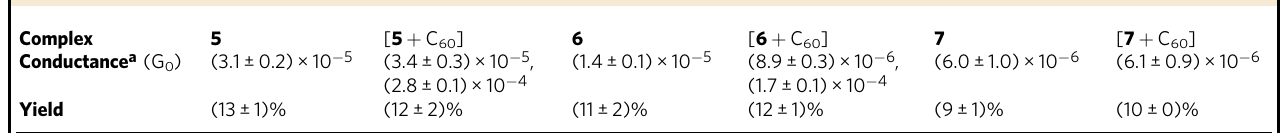
Table 1 Conductance values and corresponding junction formation yield of complexes